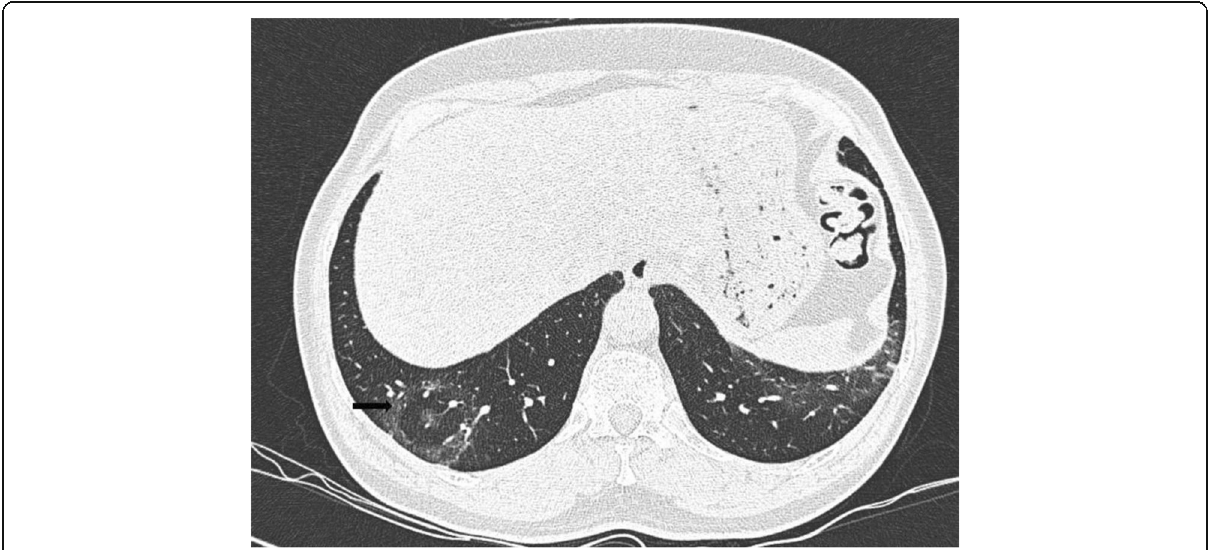
Fig. 3 Bull ’ s eye sign. Axial CT thorax of a 55-year-old COVID pneumonia patient showing central ground glass opacity surrounded by an inner ring of air and an outer ring of ground glass in the right lower